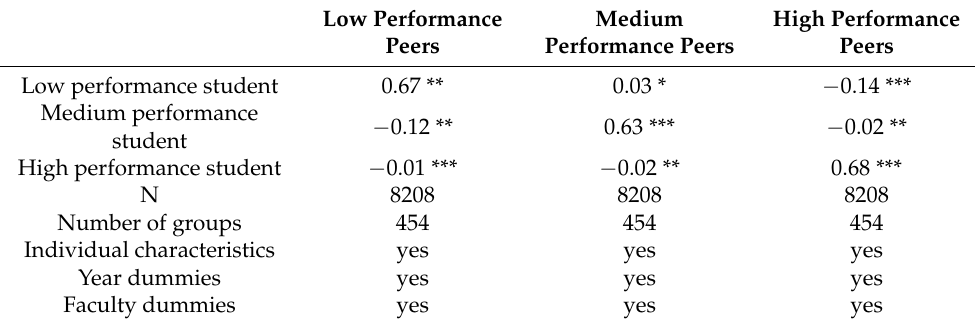
Table 6. Effects of heterogeneous peers according to student’s academic performance in Calculus